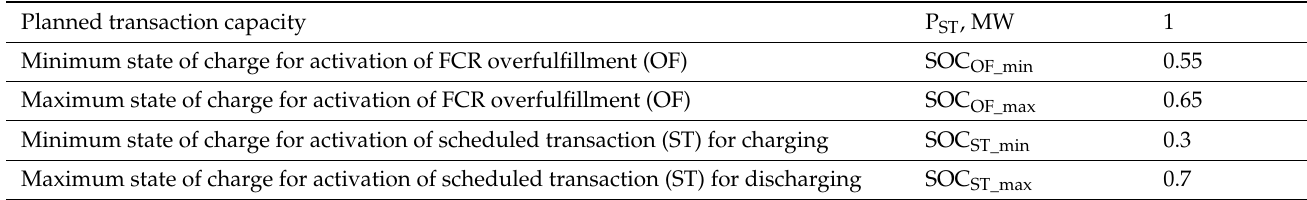
Table 5. Parameters for SOC